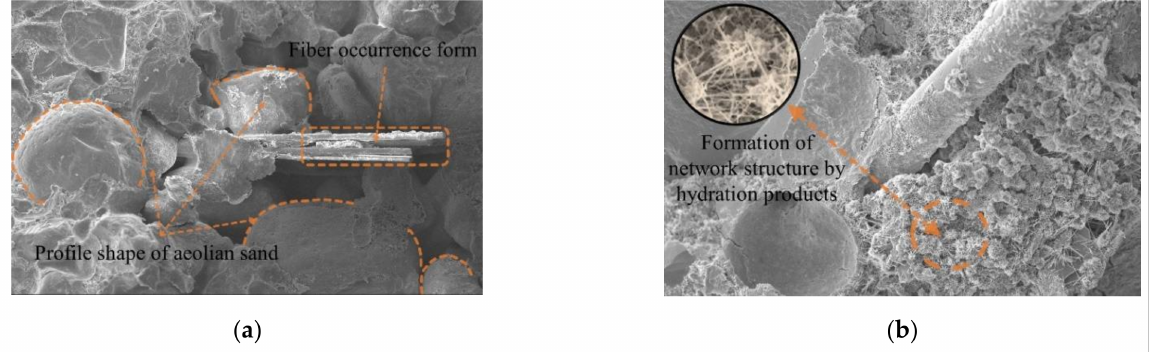
Figure 8. Scanning pictures of cement-fiber-solidified aeolian sand with SEM. ( a ) Microscopic scanning image of sample (100 × ); ( b ) Microscopic scanning image of sample (1000 ×